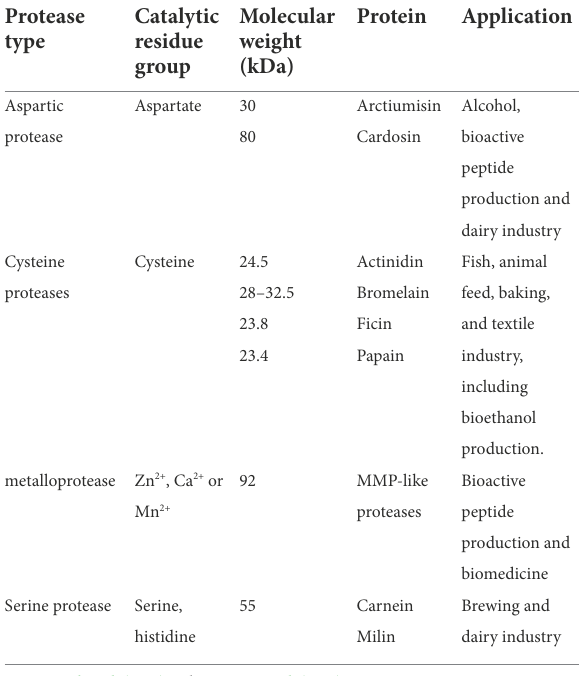
TABLE 2 Classification, general features, and examples of plant-based proteases with their industrial application. Protease